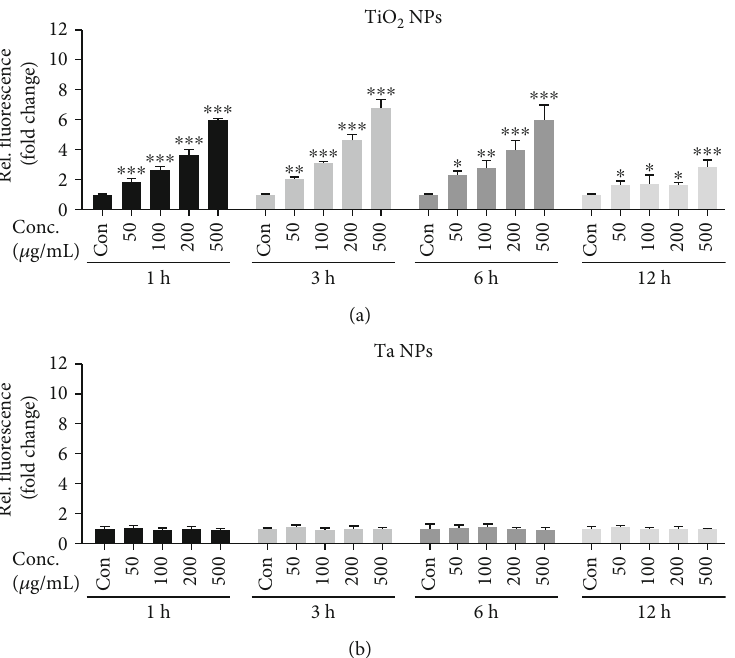
Figure 5: Endogenous ROS generation in THP-1-derived macrophages after TiO and Ta NP exposure. THP-1-derived macrophages were 2 stimulated with (a) TiO and (b) Ta NPs (50-500 μ g/mL) for 1, 3, 6, and 24h. Cells were stained with DCFH-DA (20 μ M) for 30min, and then 2 fl uorescence intensity was analyzed with a microplate reader. Fluorescence values are normalized and expressed as mean + SD as fold of untreated cells of three independent experiments ( ∗ p < 0 : 05 , ∗∗ p < 0 : 01 , and ∗∗∗ p < 0 : 001